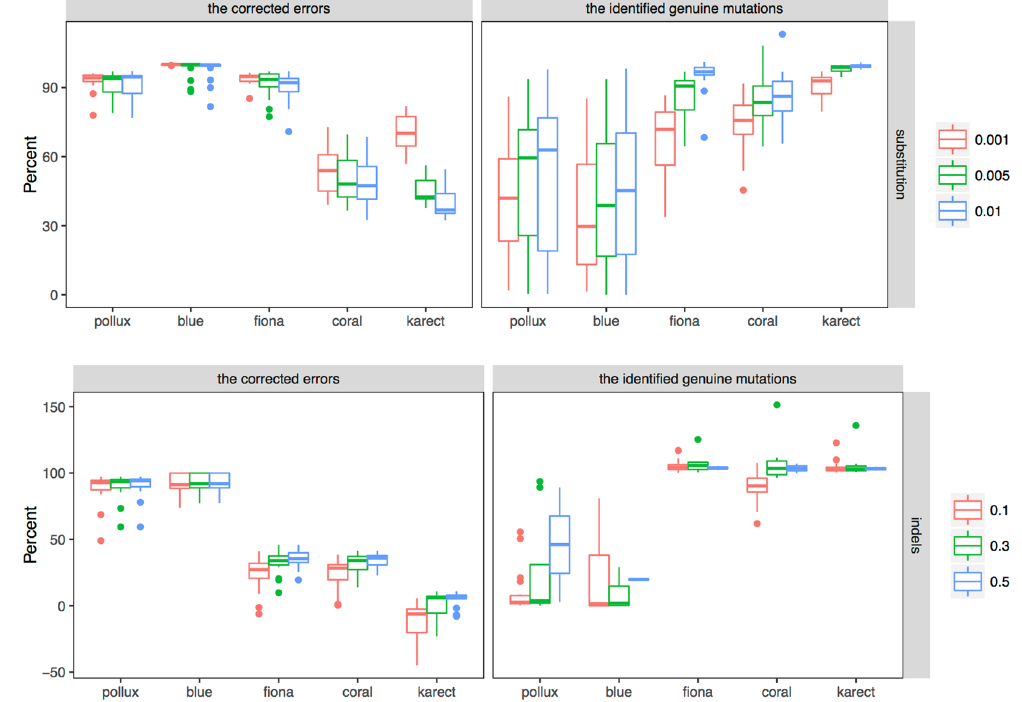
Figure 4. The proportion of the identified ‘genuine’ mutations and the corrected errors under different algorithms based on the pre- and post-corrected TEF files in the empirical PGM